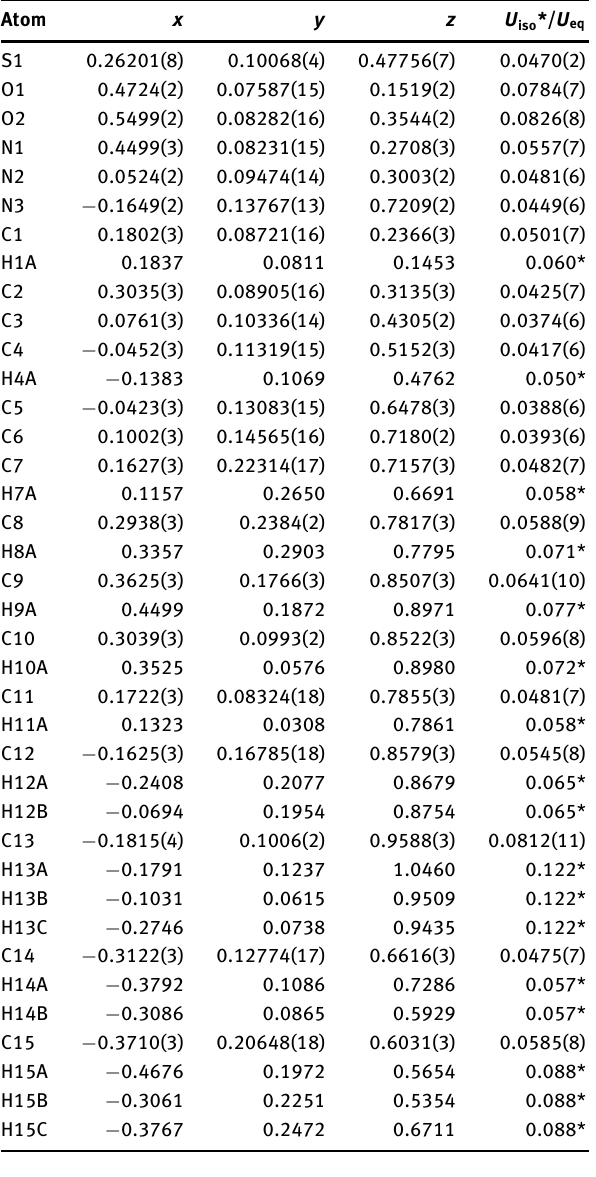
Table 2: Fractional atomic coordinates and isotropic or equivalent isotropic displacement parameters (Å 2